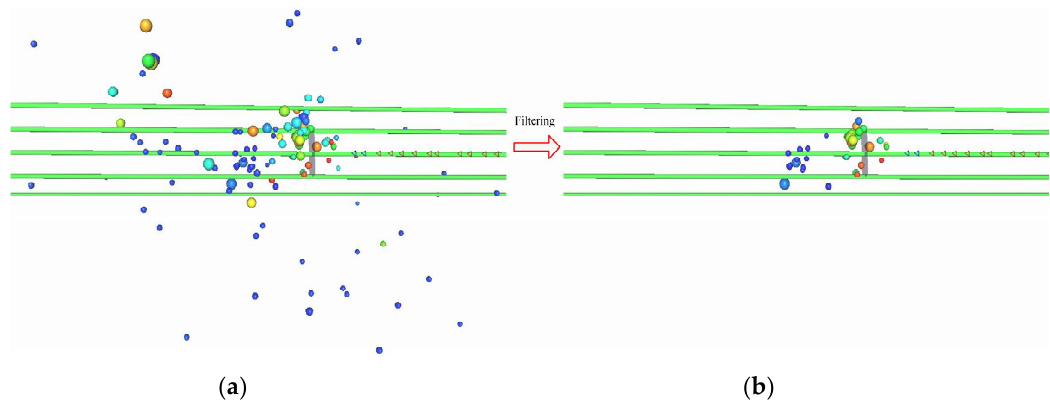
Figure 7. The comparison of MS events before ( a ) and after ( b ) filtering.